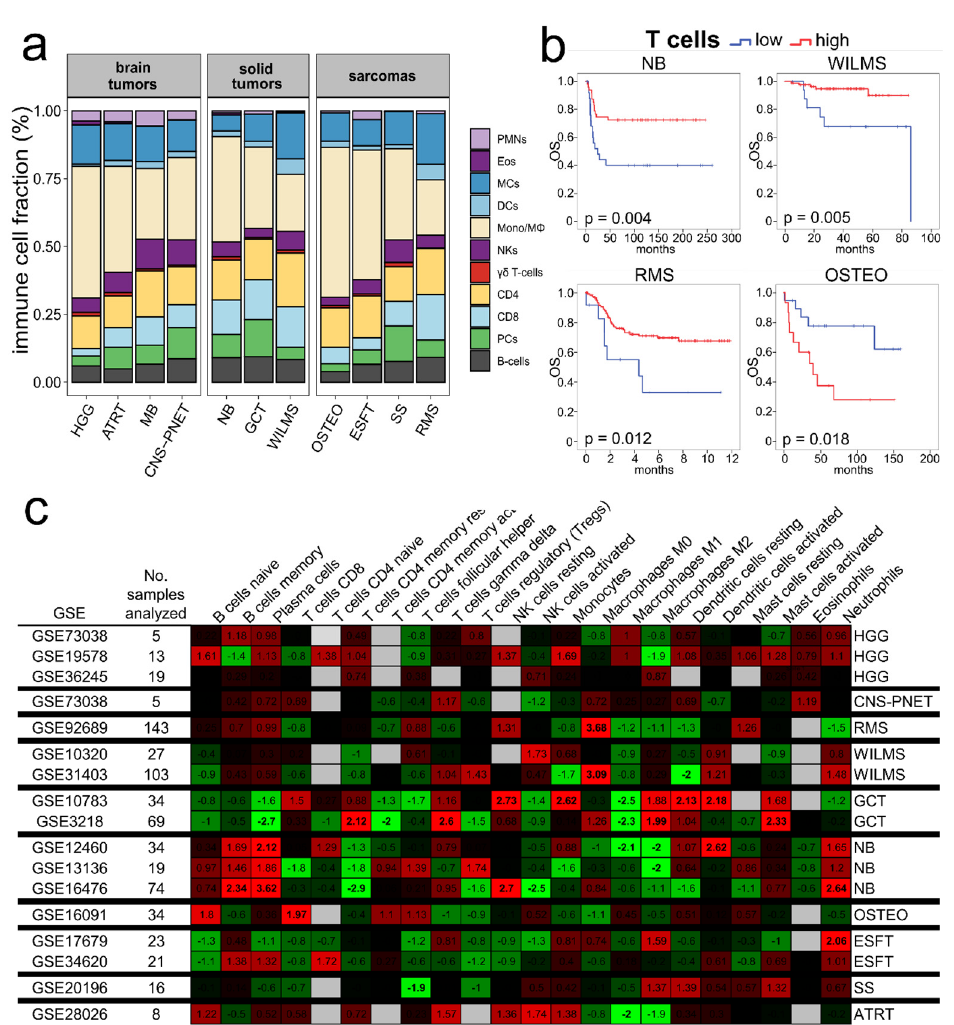
Figure 2. Immune microenvironment in pediatric tumors, determined using CIBERSORT transcriptome analysis. ( a ) Estimated relative fractions of 22 leukocyte subset across 11 pediatric tumors (“CIBERSORT-cohort)”, pooled into 11 immune populations for clarity. ( b ) Prognostic value of tumor infiltrating T-cells. Kaplan–Meier analyses showing survival with low (blue) and high (red) frequency of relative fractions of T-cells (CIBERSORT), as indicated: longer survival was observed in NB (GSE16476, n = 74, p = 0.004), in WILMS (GSE31403, n = 103, p = 0.005) and in RMS (GSE92689, n = 138, p = 0.012), whereas in OSTEO (GSE16091, n = 34) higher T-cell content was associated with reduced OS ( p = 0.018). Cutoff points of cell abundance were set at the point with the most significant separation (log-rank test) as previously described [29]. ( c ) Correlation of CIBERSORT-inferred cell type fractions and overall survival (OS). Heatmap, z-scores from univariate Cox regression on relative fractions of individual immune cell subsets. Green indicating favorable prognostic cell subsets, red indicating adverse prognostic cell subsets. |z| > 1.96 is equivalent to a two-sided p < 0.05 and are marked in bold. Abbreviations: atypical teratoid rhabdoid tumor, ATRT; Ewing’s sarcoma family of tumors, ESFT; germ cell tumors, GCT; high grade gliomas, HGG; medulloblastomas, MB; neuroblastoma, NB; osteosarcoma, OSTEO; CNS-PNETs; rhabdomyosarcoma, RMS; synovial sarcomas, SS; Wilms tumors,